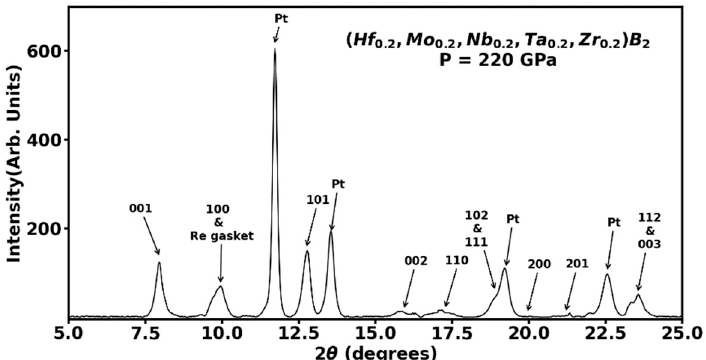
Figure 4. The angle dispersive x-ray diffraction pattern of (Hf 0.2 , Mo 0.2 , Nb 0.2 , Ta 0.2 , Zr 0.2 )B 2 sample mixed with platinum (Pt) pressure marker at the highest pressure of 220 GPa. The hexagonal AlB 2 - type phase was found to be stable to 220 GPa as evidenced by the assignment of ( hkl ) Miller indices to all the observed peaks along with the face centered cubic platinum pressure standard.